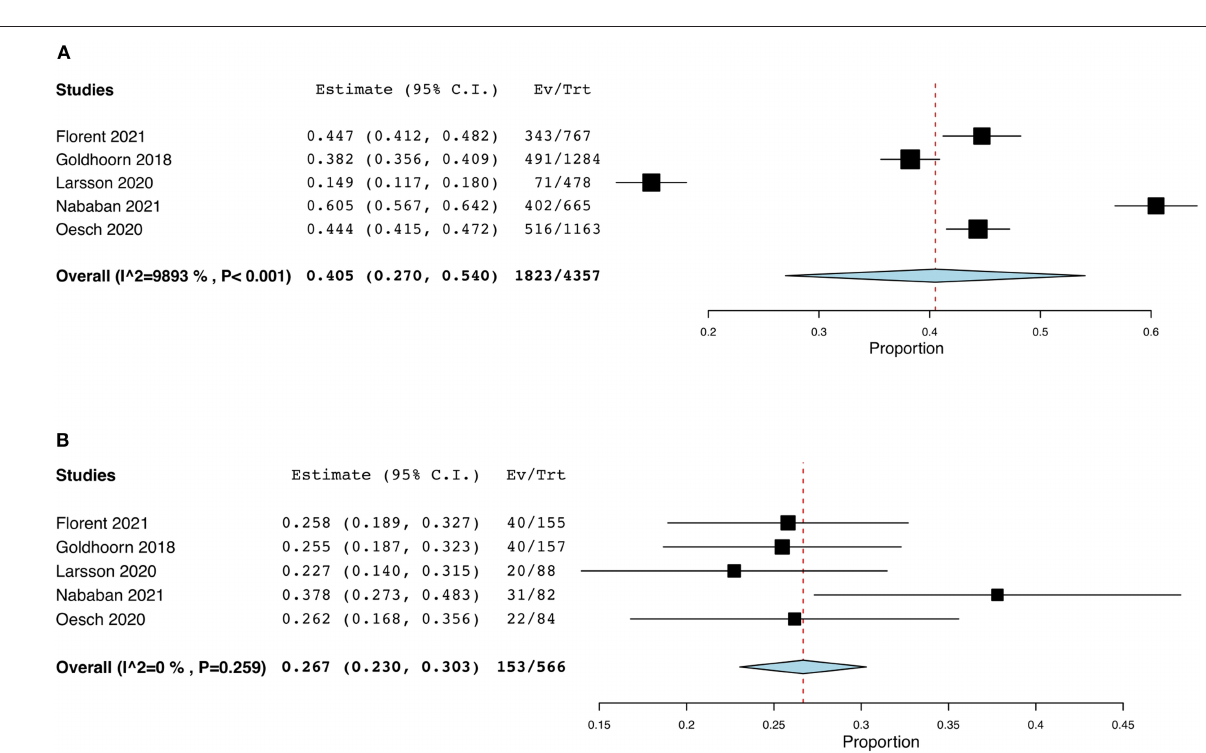
Frontiers in Neurology |